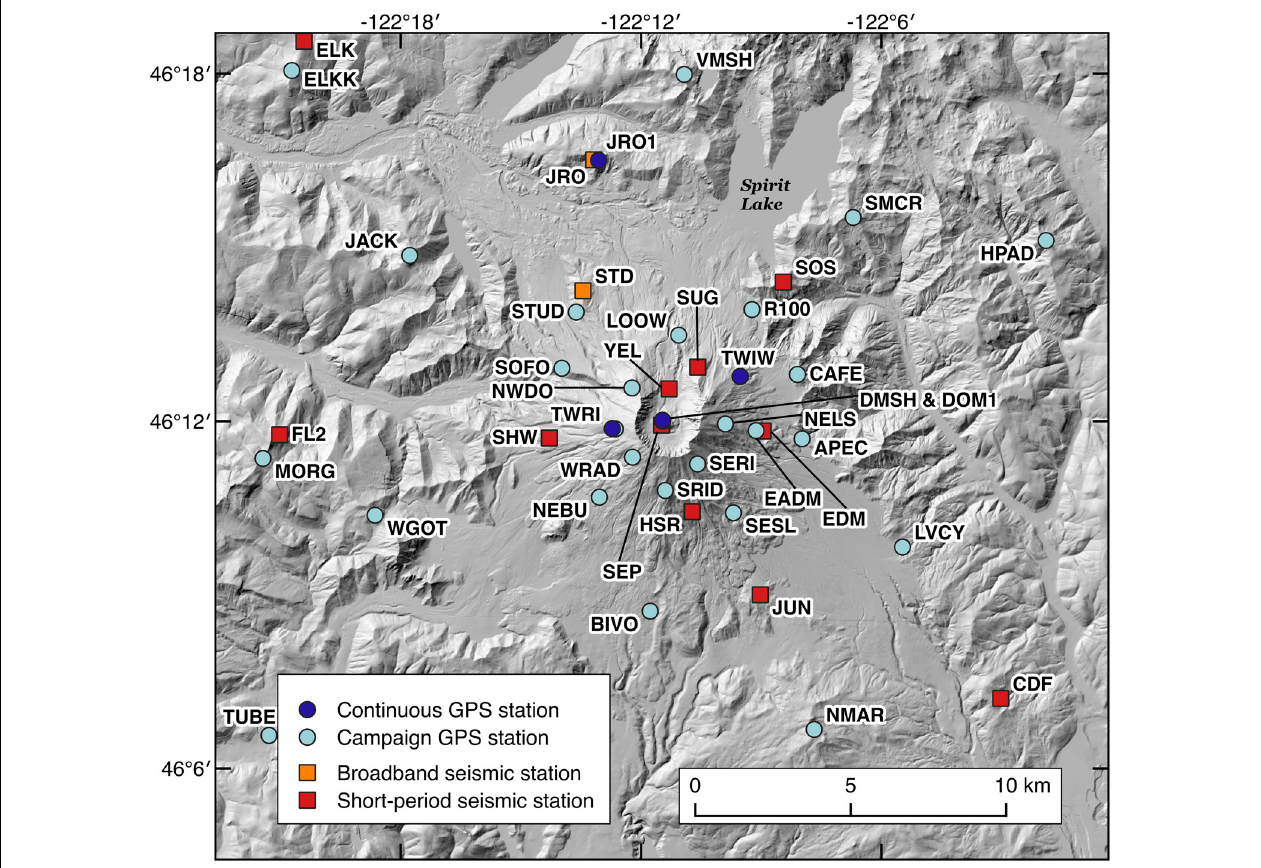
FIGURE 2 | Map showing seismic and GPS stations at Mount St. Helens prior to the 2004–8 eruption. Two broadband seismic stations, JRO and STD, and two continuous GPS stations, TWRI and TWIW, were deployed in October 2004 after the start of a shallow earthquake swarm on September 23, 2004. JRO1 was the only CGPS station operating when the swarm began; power to CGPS station DOM1 was lost in January 2004 and restored on September 27, 2004. The campaign GPS network was measured in 2000, 2003, and partially in late September–early October 2004 (see Lisowski et al., 2008). Some peripheral seismic stations are omitted to keep the map at a legible scale. Seismic station locations are from Moran et al. (2008a). GPS station locations are from Dzurisin et al. (2008). See original publications for additional information. Hillshade is an ESRI Image Service product from 2013 accessed through ArcGIS Online and depicts post-1980 topography.